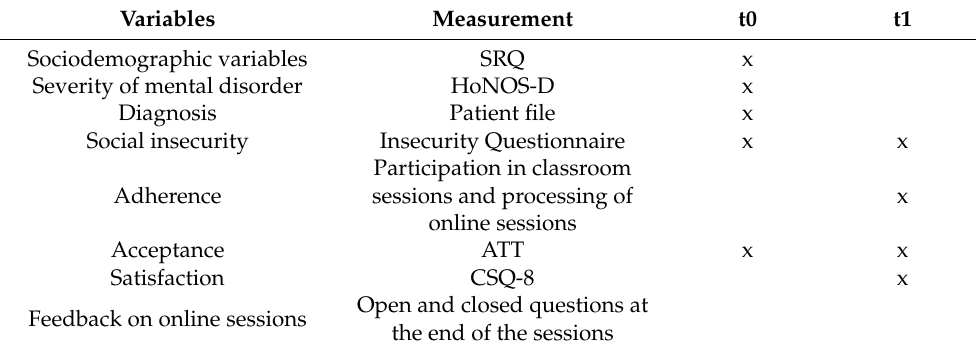
Table 2. Outcomes and assessment